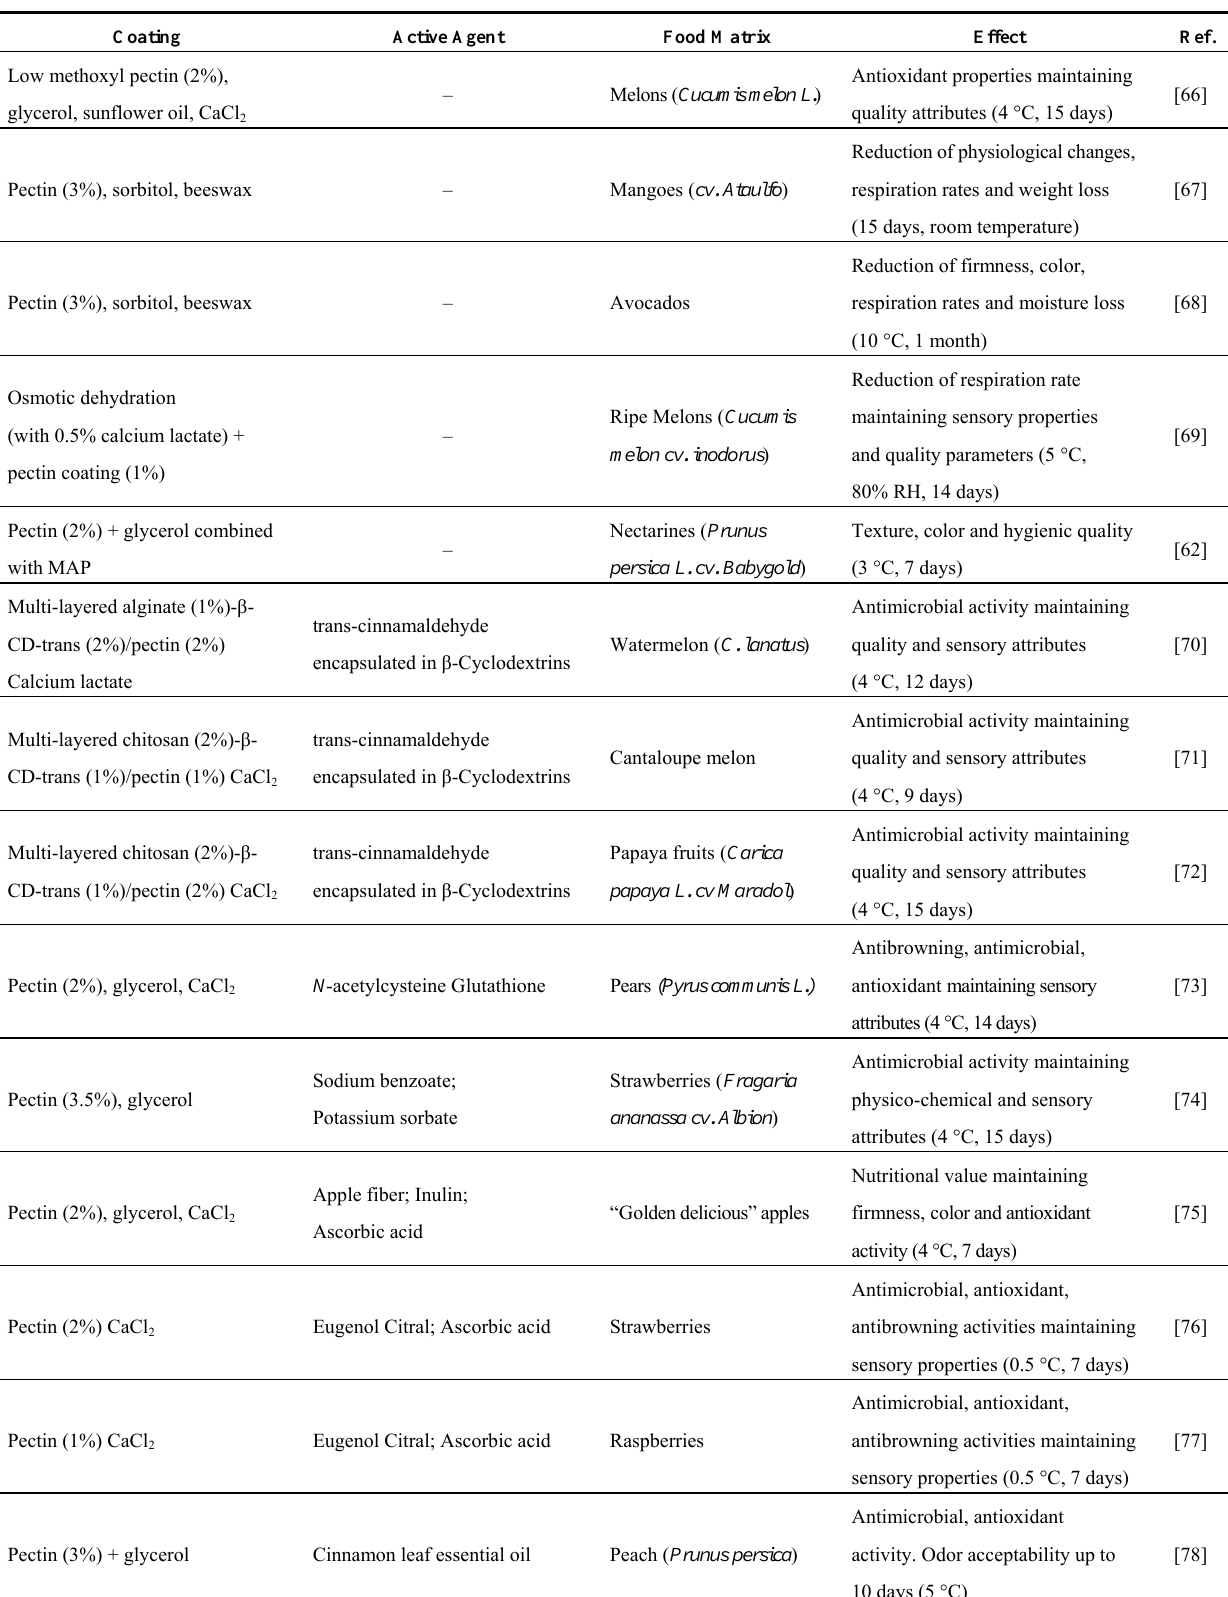
Table 3. Pectin-based coatings to extend shelf-life of fresh fruits and vegetables.